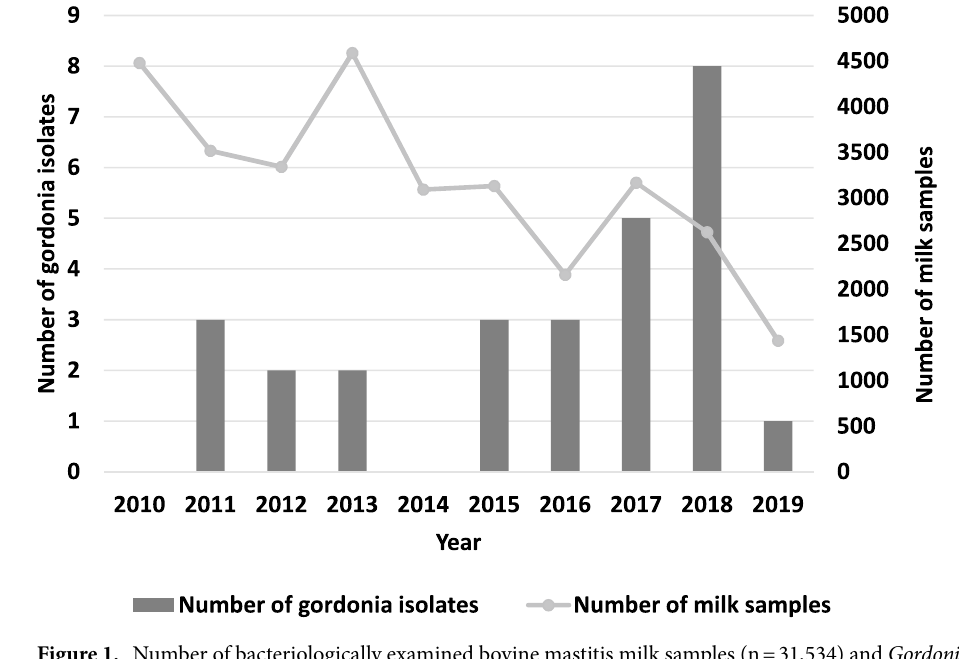
Figure 1. Number of bacteriologically examined bovine mastitis milk samples (n = 31,534) and Gordonia sp. isolates (n = 27) per